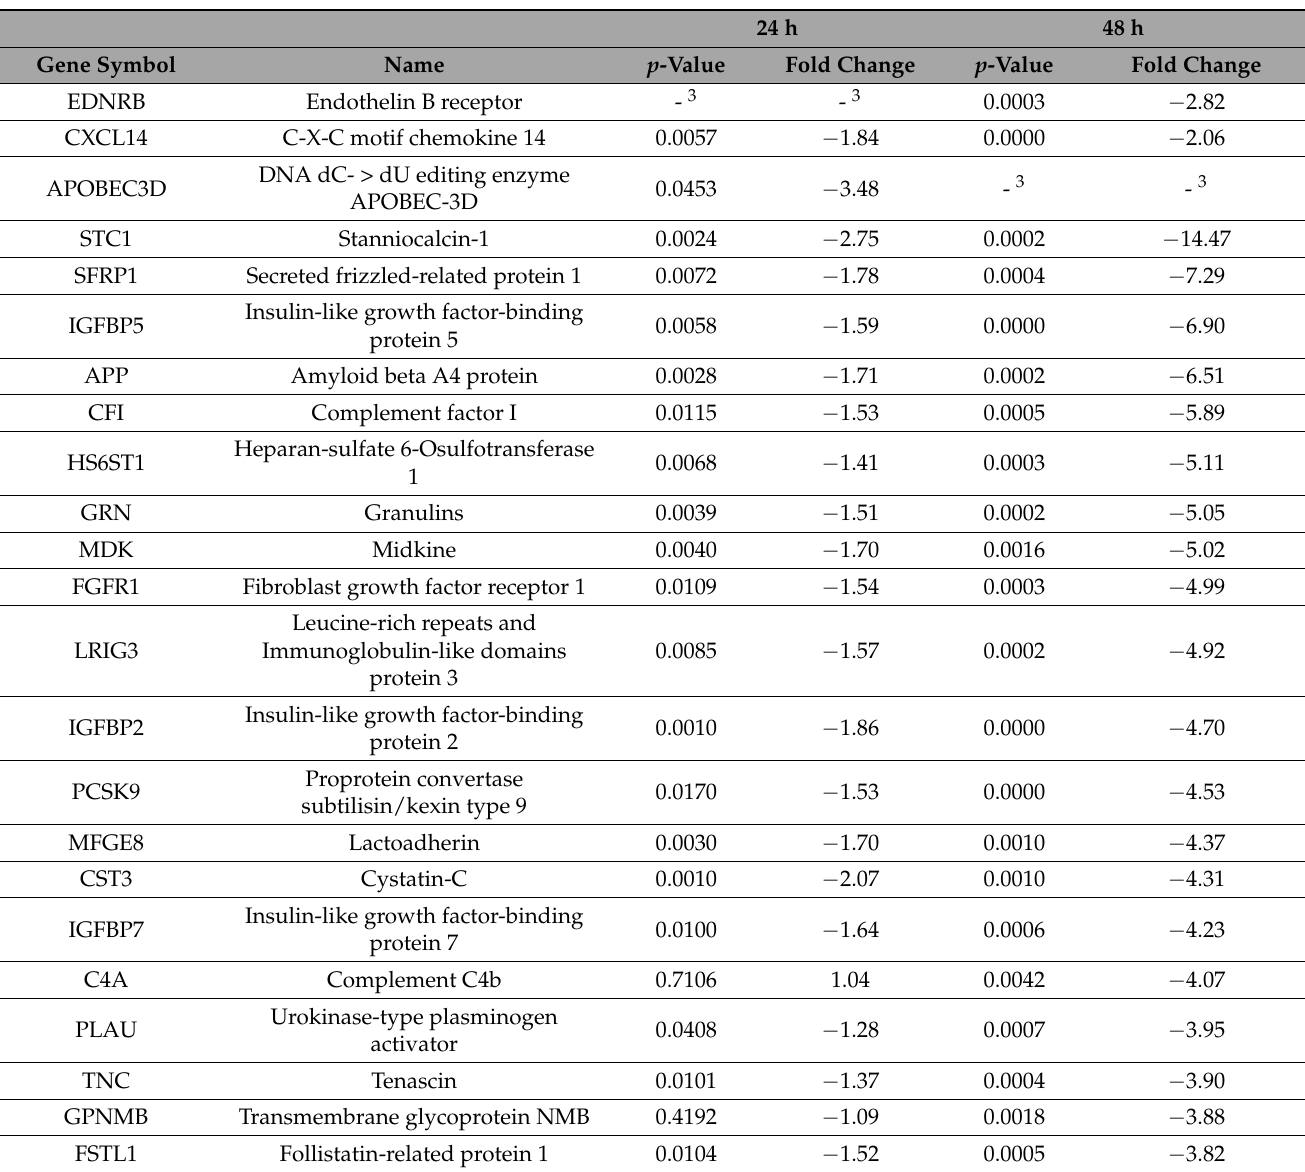
Table 2. Number of significantly downregulated and upregulated targets in ZIKV-infected U251 cells at 24 and 48 hpi 1,2